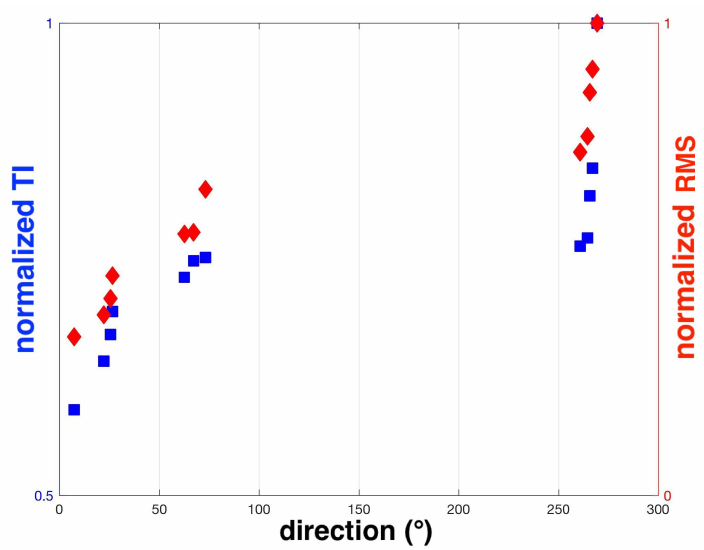
Figure 8. Normalized RMS (root mean square) vs. nacelle position for SGM11 (red scale) and numerical TI (turbulence intensity) extrapolated at the corresponding wind direction (blue scale) at the site of